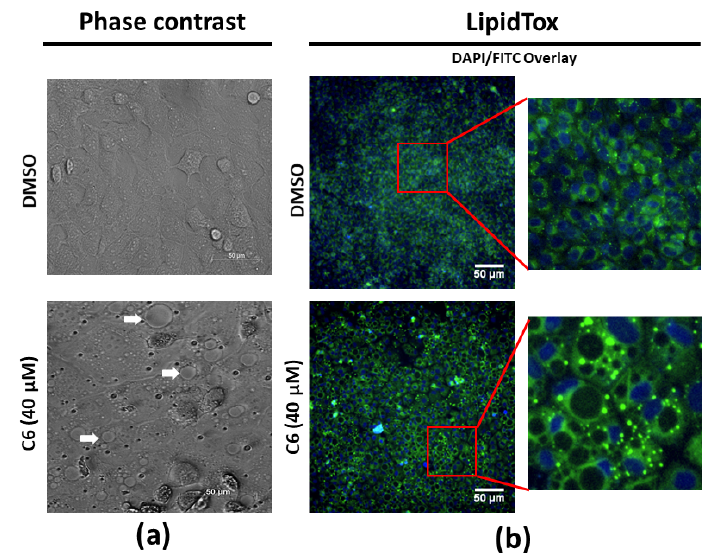
Figure 8. Evaluating lipid droplet accumulation in the MCF-7 cell line. ( a ) Morphological changes induced by C6 observed with phase contrast micrographs; white arrows indicate structures of interest. ( b ) Typical micrographs obtained for MCF-7 cells stained with HCS LipidTOX TM Green neutral lipid stain after treatment with C6.